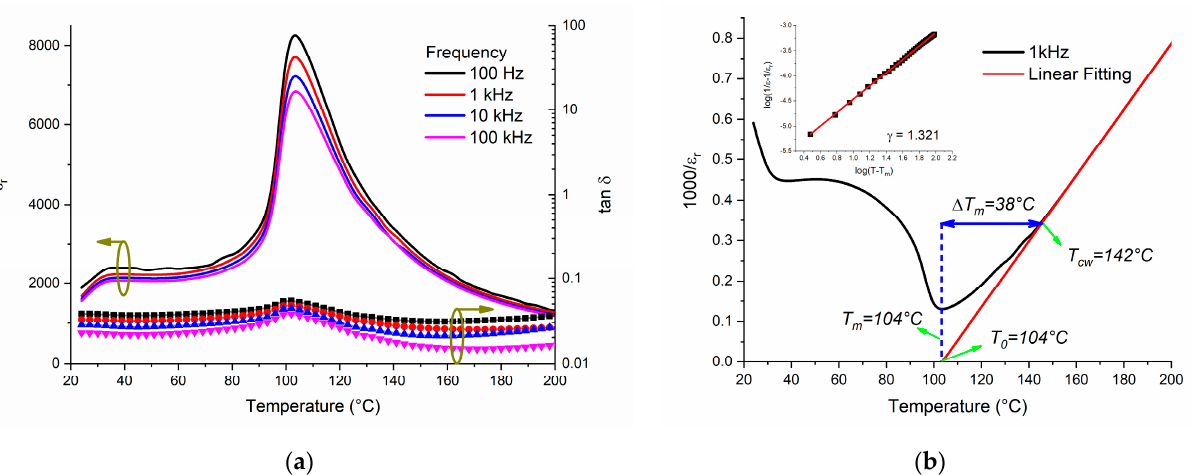
Figure 2. ( a ) Temperature-dependence of dielectric permittivity and losses for BCTZ8-5 sintered ceramics. ( b ) Curie–Weiss fitting curve for BCTZ8-5; the inset shows the plot of log (1/ ε − 1/ ε r ) vs. log ( T − T m